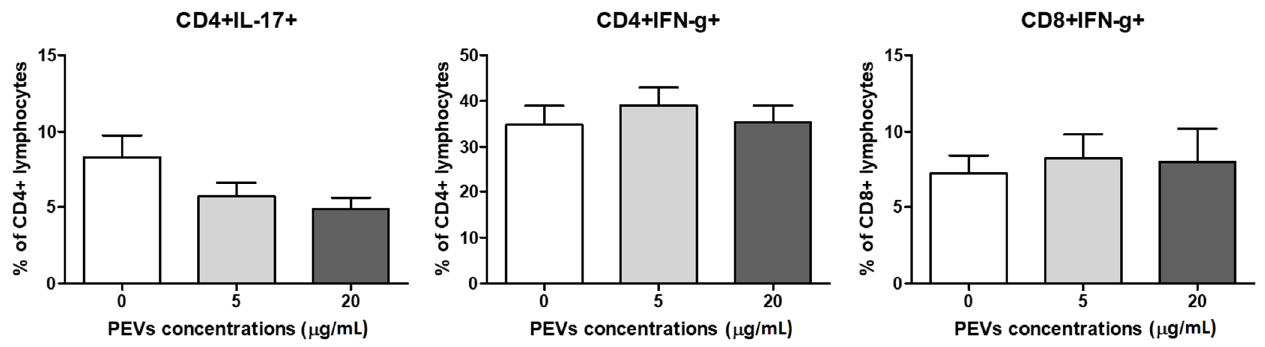
Figure 5. Changes in frequencies of canine CD4 + IFN γ + and CD8 + IFN γ + and CD4 + IL17 + lymphocytes after 5 days of culture of PBMCs in a 37 °C, 5% CO 2 environment with ConA and IL-2 presence and PEV1/ PEV2 or without PEVs ( n = 8). The results are presented as the mean ± SEM.